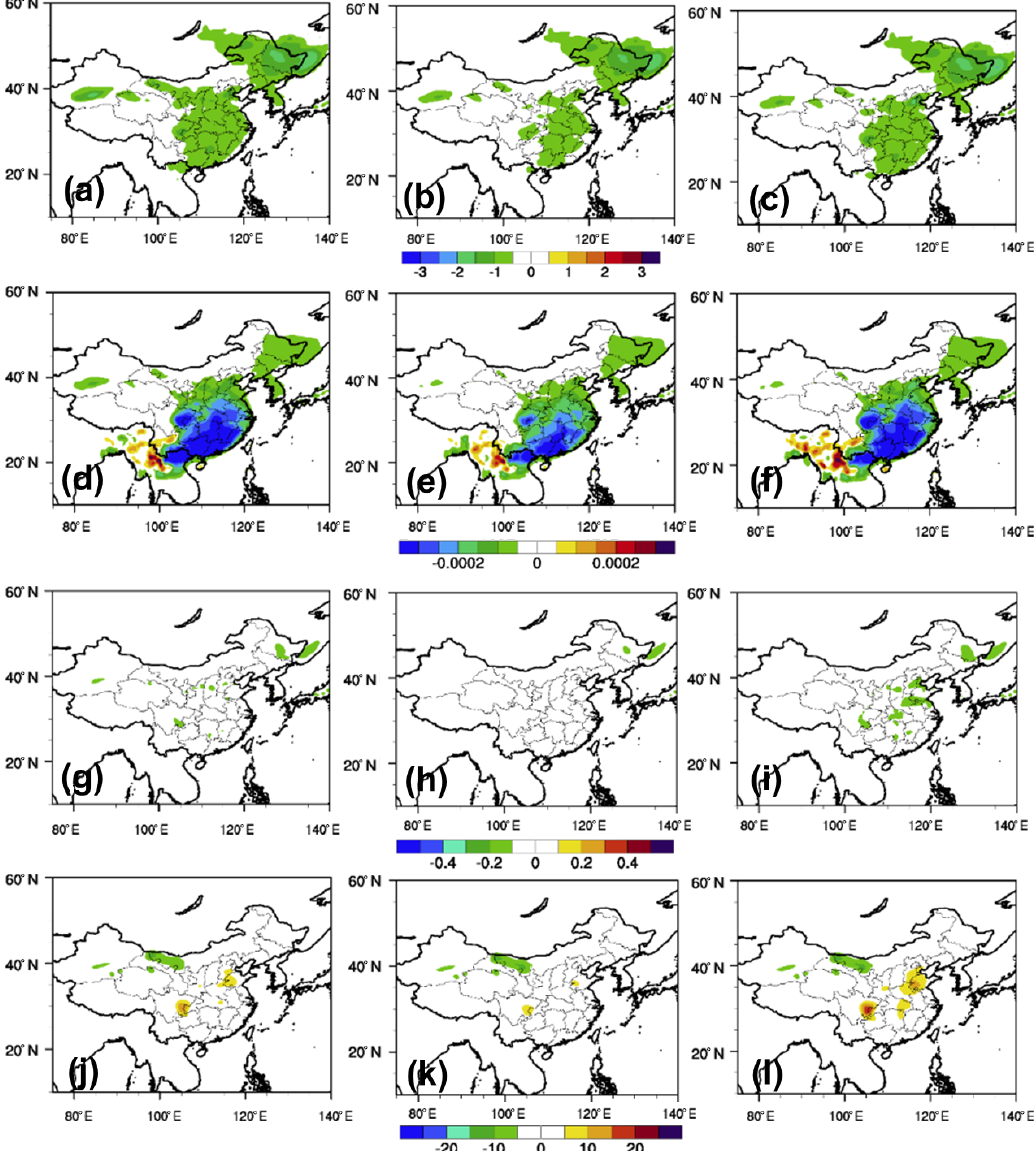
Figure 8. Monthly (January 2010) mean RIEMS-Chem modeled changes in T2 ( ◦ C), Q2 (kgkg − 1 ), WS10 (ms − 1 ), and PM 2 . 5 (µgm − 3 ) from different simulations: external mixing assumption (first column), internal mixing assumption but without BC (second column), and internal mixing assumption but with doubled BC (third